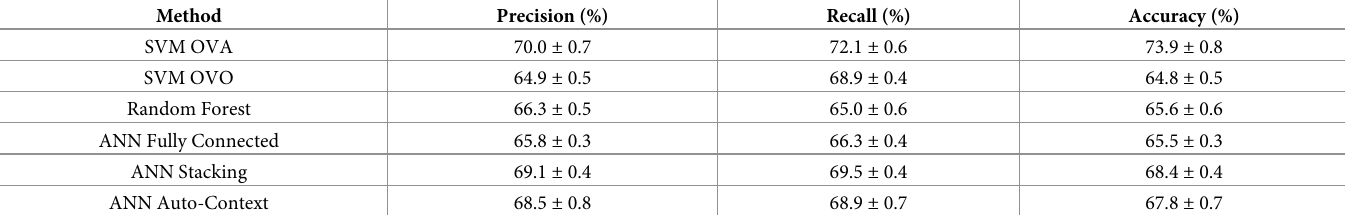
Table 2. Summarization of the test set classification results for the standard features-based algorithms considering the entire dataset, evaluated in terms of preci- sion, recall and accuracy